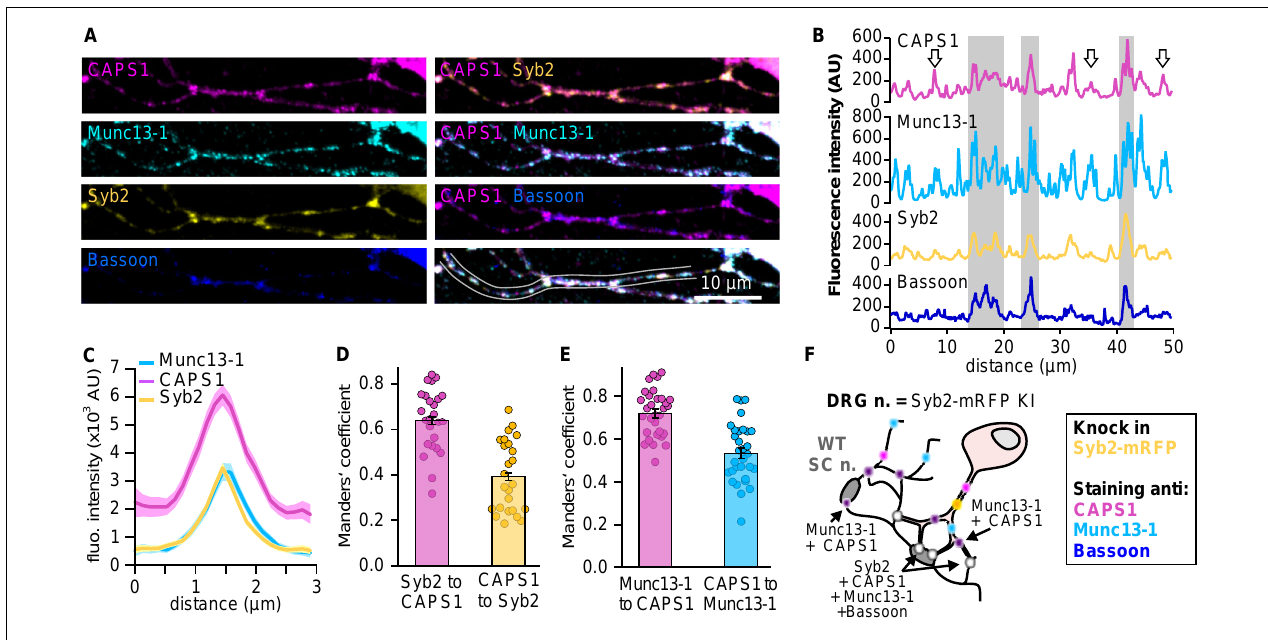
FIGURE 1 | CAPS1 clusters are distributed over synaptic and extra-synaptic sites. (A) Representative neurite of a DRG neuron (DIV6) derived from synaptobrevin2-mRFP (yellow) knock-in mouse immuno-labeled with anti-CAPS1 (magenta), anti-active zone protein Munc13-1 (cyan) and anti-bassoon (blue) antibodies. (B) Line profiles of the fluorescence intensities along the neurite outlined in (A) in all four channels. The gray squares correspond to synapses identified by high anti-bassoon fluorescence. Arrows indicate extrasynaptic sites in which CAPS1 and Munc13- co-localize. (C) Average line profile diagram for CAPS1 over synapses selected according to co-localized synaptobrevin 2-mRFP, Munc13-1 and bassoon (not shown) signals ( n = 81 synapses; N experiment = 3). (D) Manders’ overlap coefficients of synaptobrevin 2-mRFP and CAPS1 represented as bar graph of the average ± SEM over the scatter dot plot of individual neurite values ( n = 25 neurites; N experiment = 3). (E) Manders’ overlap coefficients of Munc13-1 and CAPS1 represented as bar graph of the average ± SEM over the scatter dot plot of individual neurite values ( n = 31 neurites; N experiment = 3). (F) Schematic representation of the experimental design. Light blue dots indicate Munc13-1-positive puncta and yellow dots correspond to synaptobrevin 2-mRFP on SVs or LDCVs at extra-synaptic locations in DRG neurons. Cytosolic distribution of CAPS1 is shown in magenta while enrichment at heterotypic synapses is represented with white dots.